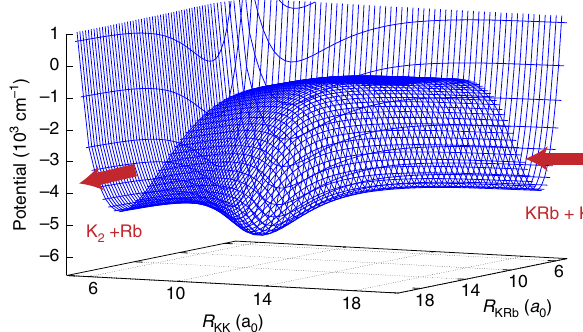
Figure 7 | K–KRb potential energy surface for collinear geometry. A two-dimensional cut through the energetically lowest 2 A 0 adiabatic potential energy surface of the KRbK trimer as a function of the K (cid:2) Rb and K (cid:2) K bond lengths along the collinear geometry. The zero of energy corresponds to the energy of three well-separated atoms. The arrows indicate the entrance and exit channels of the chemical